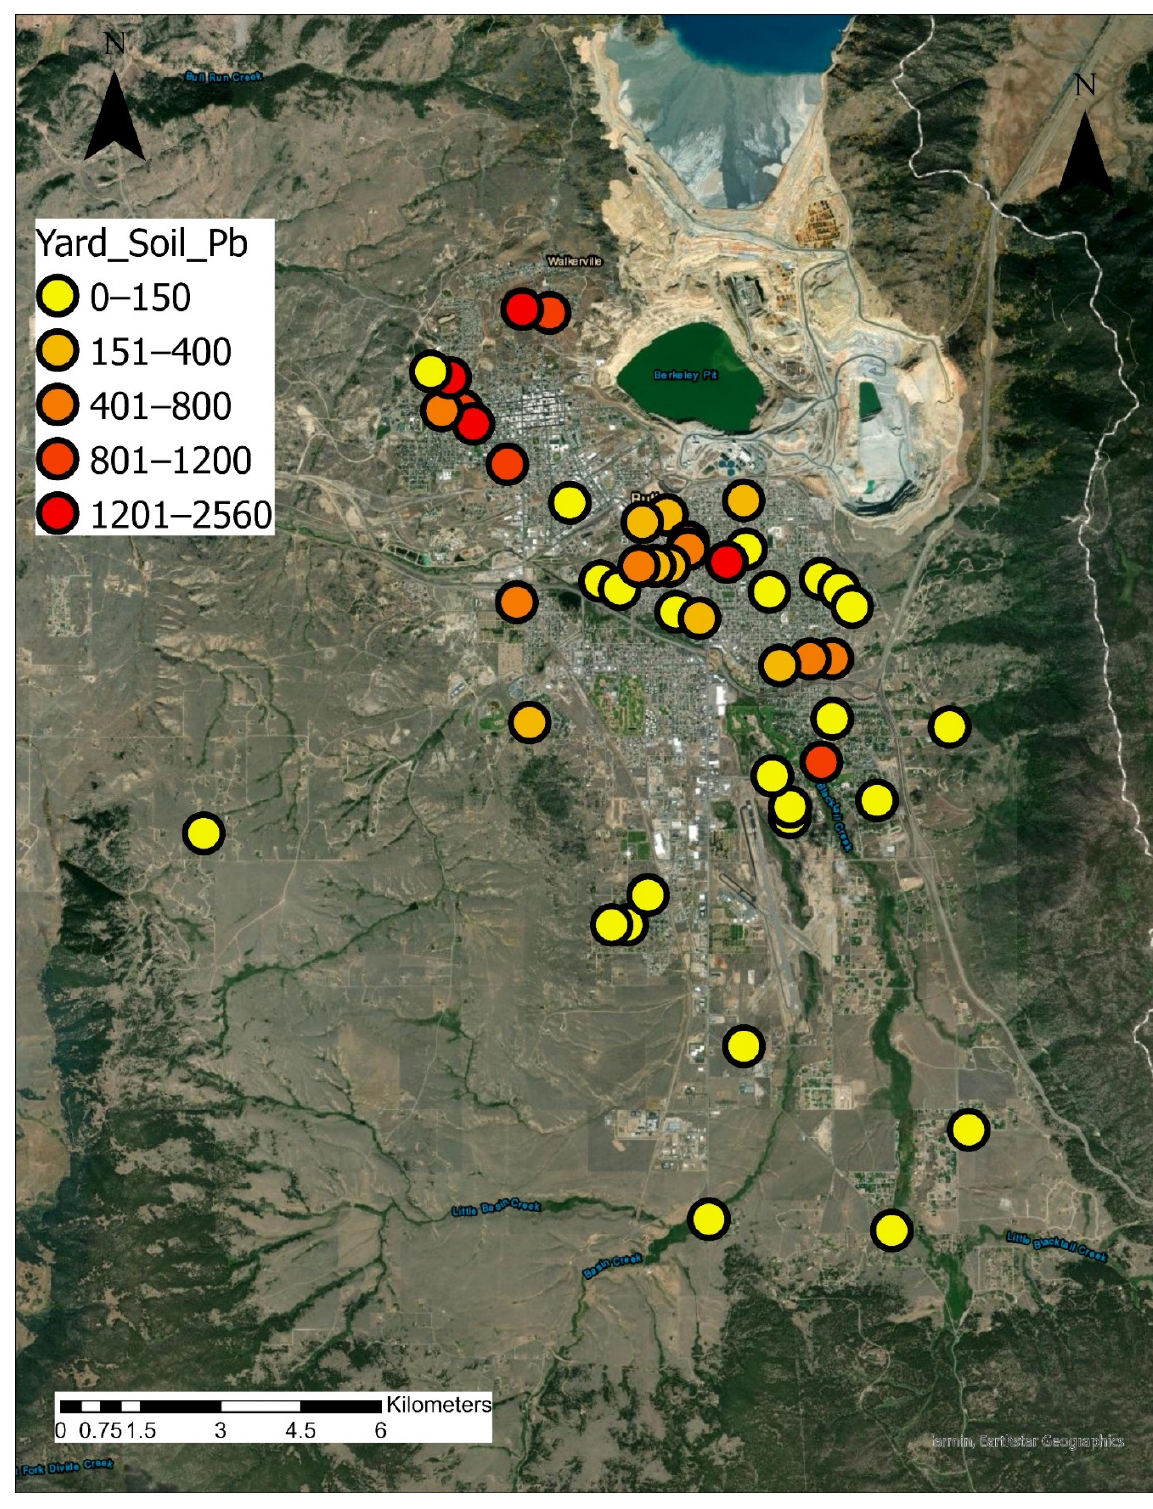
Figure 4. Aerial view of Butte showing Pb concentrations at each residence sampled. Note that distribution of sites throughout the city, both in the midst of historic mining activities and farther away. Levels of Pb shown represent the maximum value of front yard, back yard, and garden soil at each site.